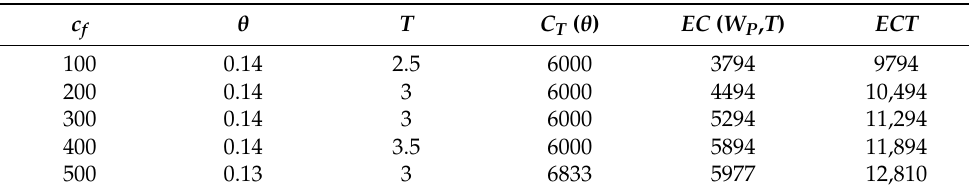
Table 4. Effect of follow-up cost on the optimal treatment decision and monitoring strategy.